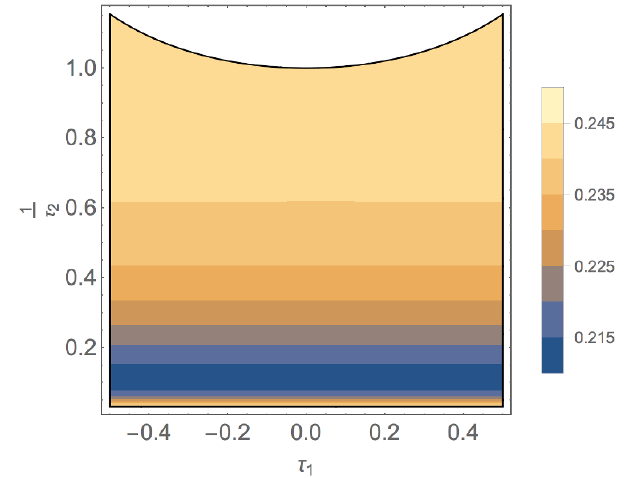
Figure 7 . A sample (cid:28) -integrand (with integration measure d 2 (cid:28)=(cid:28) 2 over the fundamental domain, after integration in z , in coordinates ( (cid:28) 1 ; 1 =(cid:28) 2 ), in the case ! = 0 : 8 i